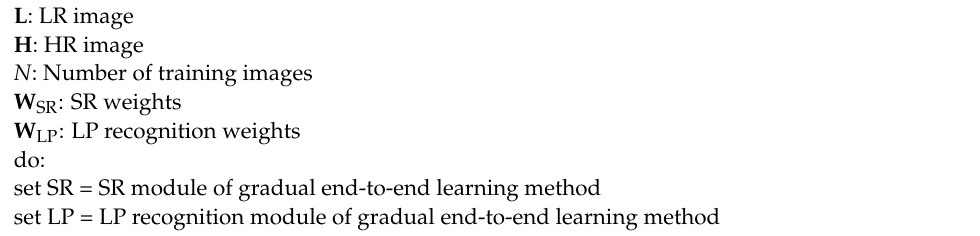
Algorithm 3. A pseudocode of the gradual end-to-end learning method based on weight